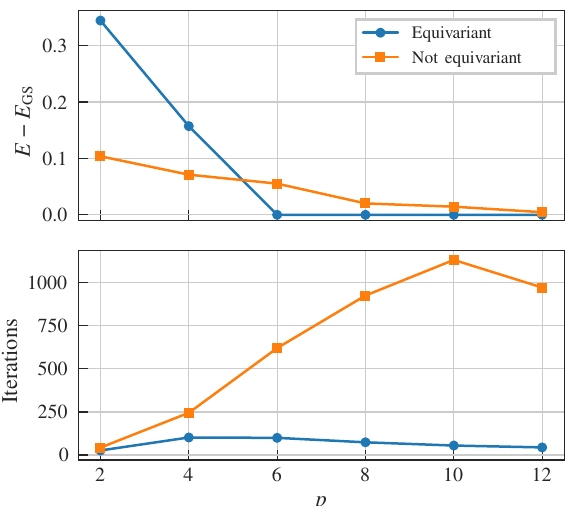
FIG. 9. Comparison of the equivariant QAOA ansatz with the nonequivariant QAOA (cid:14) ansatz for the TFIM on N = 10 spins with field g = 1. For every number of layers p , we perform 20 experiments with random initializations of the parameters and plot the difference between the mean achieved energy and the ground state energy (top) and the number of iterations necessary to reach it (bottom). We see that, for p ≥ N / 2, the equivariant ansatz performs better in both figures of